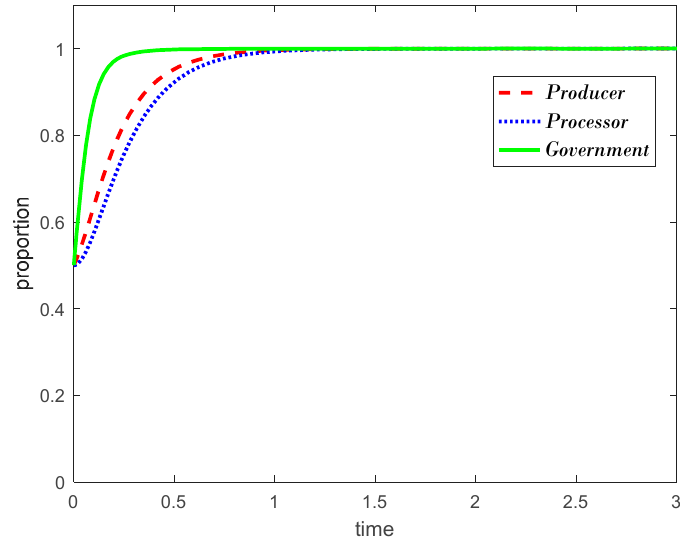
Figure 6. The evolutionary path of case 4.